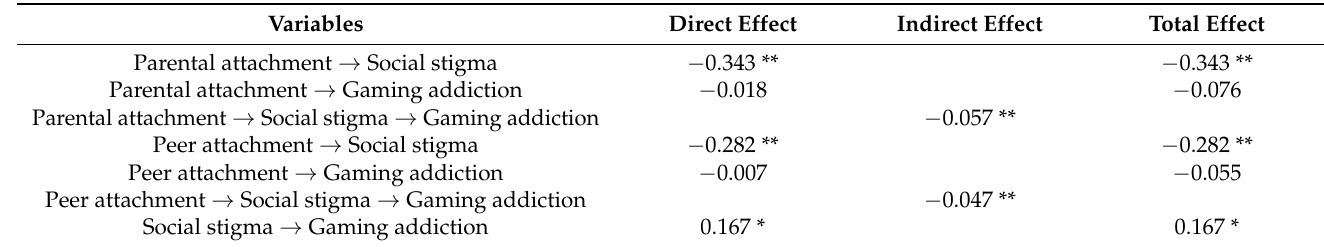
addiction using 2000